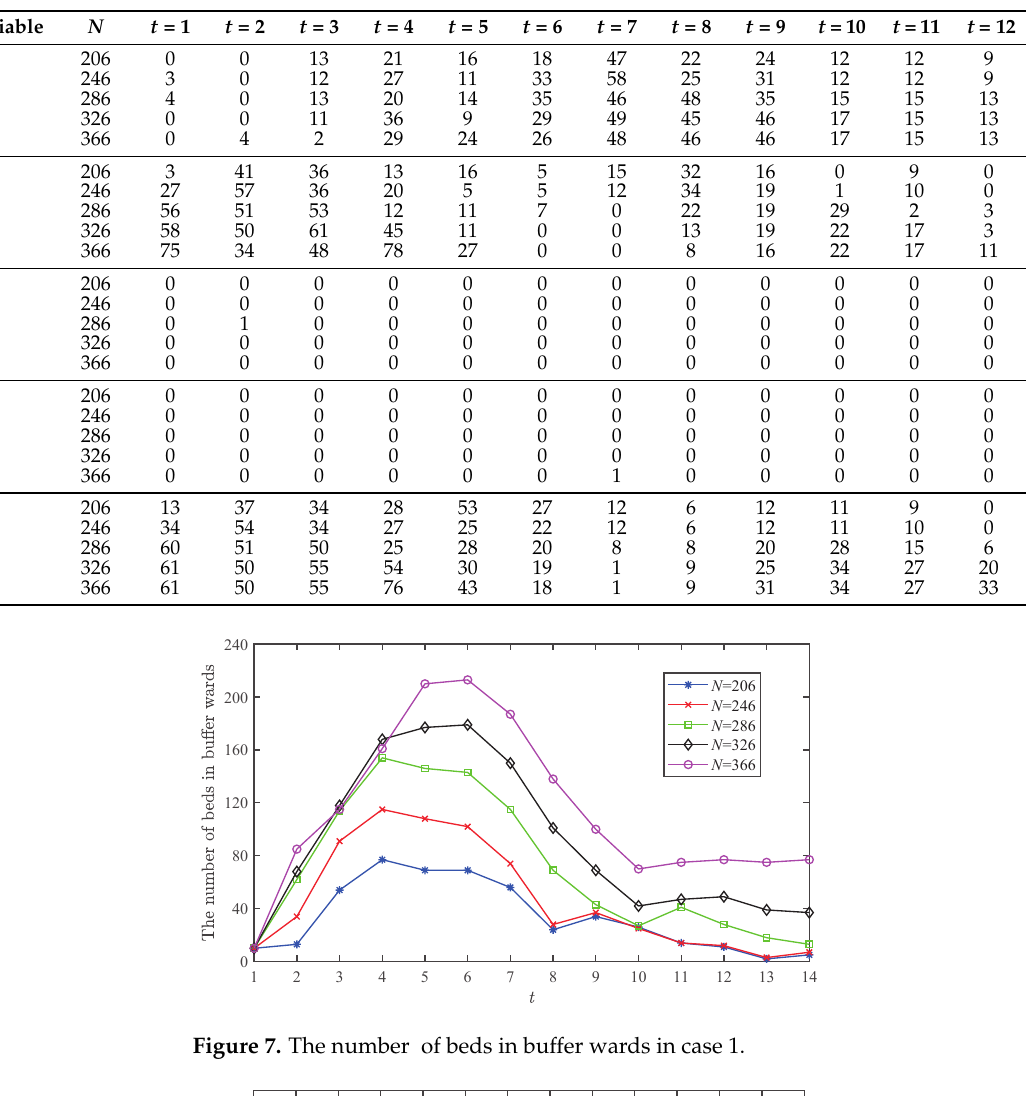
Table 5. Comparison of optimal decision schemes in case 1.